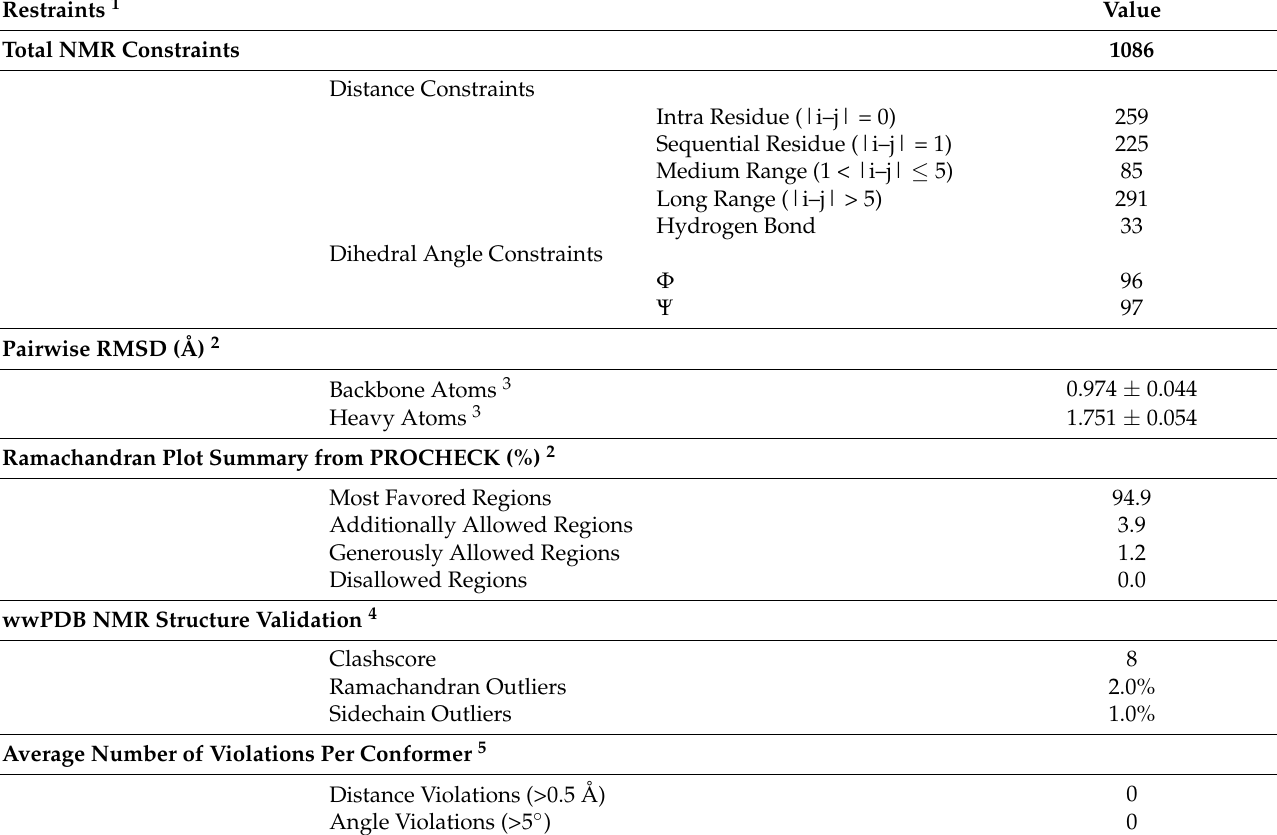
Table 1. Statistics of the solution structure of SsoSSB 1–114 at 50 ◦ C. The 20 lowest energy structures were calculated using NMR